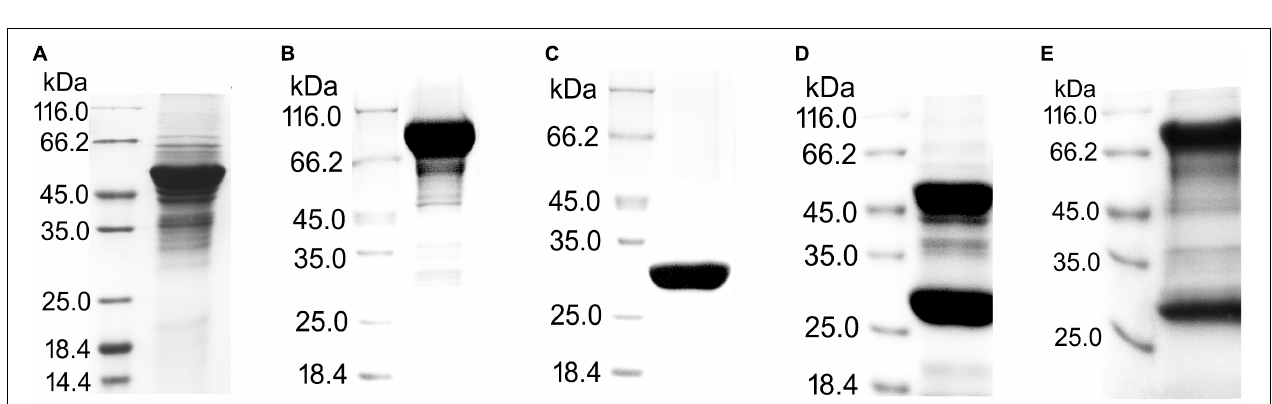
FIGURE 1 | Impact of Hsp60 on the urease activity. (A) Purification of recombinant Hsp60 fused with a 6 × His tag on its C-terminus. (B) UreA fused with a His tag on its C-terminus. (C) UreB fused with a His tag on its C-terminus. The purification of proteins fused with His tags was performed routinely: The supernatant of disrupted bacteria was passed through the Ni-NTA resin at a flow rate of 0.5 ml/min. After being washed with Tris-HCl (50 mM, pH 8.0), the beads were eluted with 250 mM imidazole. For Hsp60, it was further purified with Sephadex G-75 resin at a flow rate of 1 ml/min in HEPES buffer (for urease activity assay) or Tris-HCl (for pull-down assay), or PBS buffer (for SPR analysis). (D) Interaction confirmation by examining the impact of Hsp60 on urease activity of Helicobacter pylori lysate. H. pylori cells were washed and subsequently resuspended in 50 mM HEPES buffer (pH 7.5) to 10 9 CFU/ml for sonication. The lysate (containing unbroken cells and membrane fractions) or the lysate supernatant (90 µ l) was mixed with 100 µ l of Hsp60 (0.2 mg/ml), followed by incubation at 37 ◦ C for 30 min. Then 100 µ l of urea solution (62.5 mM in HEPES buffer) was added and incubated for another 30 min at 37 ◦ C. The reaction was stopped by adding 375 µ l of regent A (containing 10 g/l phenol and 50 mg/l sodium pentacyanonitrosylferrate(III) dihydrate) and 375 µ l of regent B [containing 5 mg/ml sodium hydroxide, 0.044% (v/v) sodium hypochlorite] successively. After a further 30-min reaction at 37 ◦ C, the absorbance at 620 nm was measured. The activity of lysate or lysate supernatant with pre-boiled Hsp60 was taken as control (100%). All experiments were repeated at least three times.